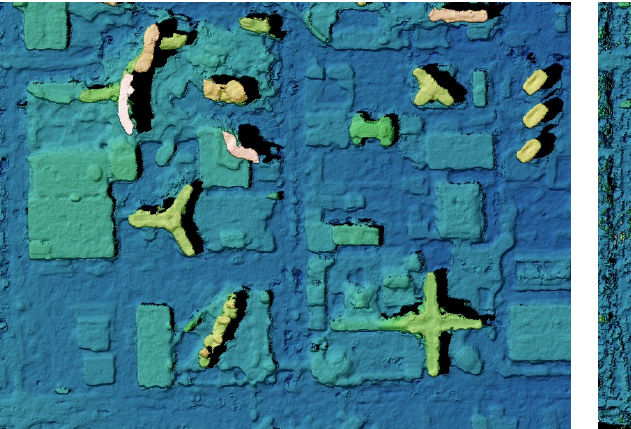
(a) Pairwise matching of three images (b) 20 images against one master image, without regularization